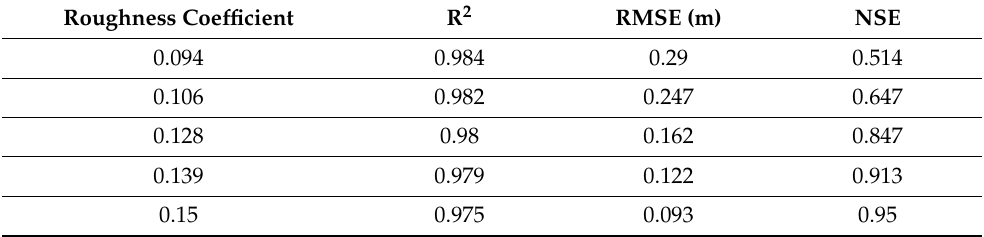
Table 1. Sample Raspy-Cal output